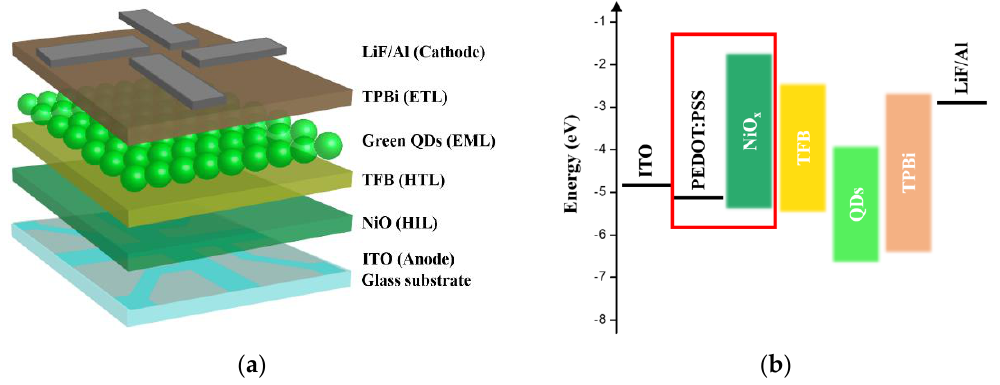
Figure 3. ( a ) Device structure and ( b ) energy band diagram of a standard-structured QLED with NiO as the HIL.